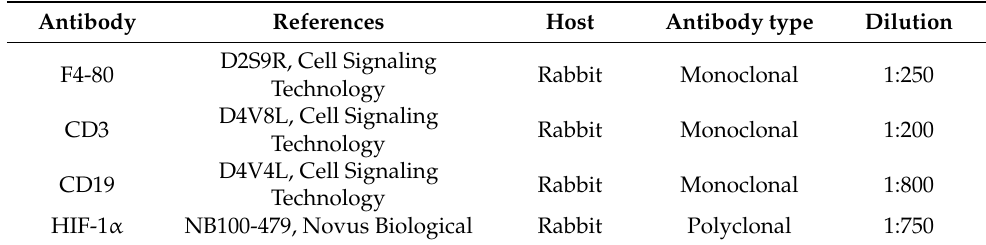
Table 1. Antibodies used for immunohistochemistry.